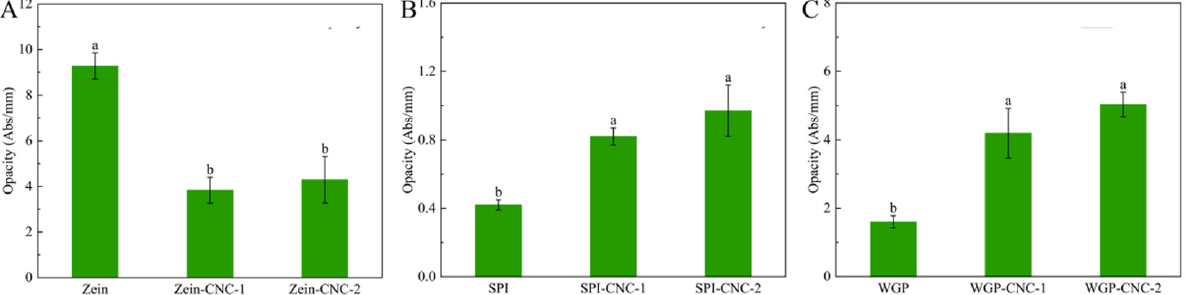
Figure 2. ( A – C ) The opacity of Zein/SPI/WGP-based films (Zein: zein; SPI: soy protein isolate; WGP: wheat gluten protein). Different letters (a–c) indicated significant differences ( p < 0.05).